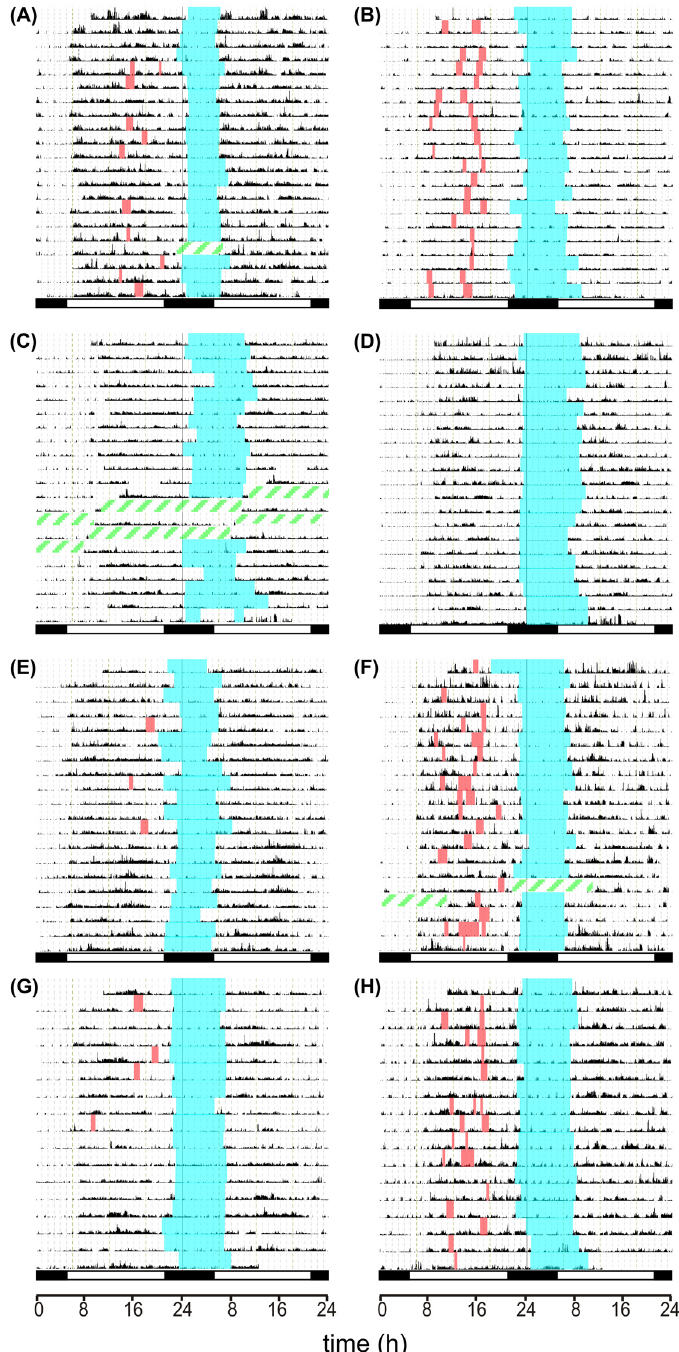
Fig 3. Individual actigraphs of the control/AD patient couples. Actigraphs from controls (A,C,E,G) and AD patients (B,D,F,H) are depicted, representing the AB, CD, EF and GH couples. The activity was recorded during 21 days (A-F) or 17 days (G,H). The record of activity (black area) from the Actiwatch analysis was completed with manual marking of nighttime sleep periods (blue area) and daytime naps (orange area) according to data from the individual sleep diaries. The green dashed areas represent intervals when the device was not